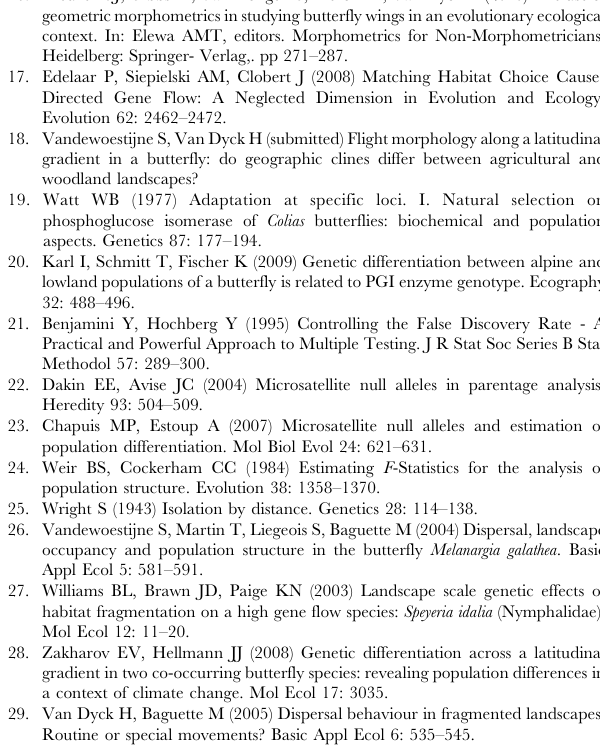
populations ( N ), dotted line: woodland populations ( D ). Significance levels are available in Table S4. Figure S2 Genetic and phenotypic differentiation. Fst and Pst values for agricultural-agricultural ( N ) and woodland-woodland ( D ) population pairs of size and dispersal relevant morphological variation (relative thorax, aspect ratio, wing loading and melanization). All values are with 95% confidence intervals. Figure S3 Spatial genetic autocorrelation correlogram of populations. Population pairs within A) agricultural and B) woodland landscapes. Dotted lines represent upper and lower 95% CI around the null hypothesis (no spatial structure). Filled dots represent significant r values (p , 0.05), empty dots non- significant values. Error bars indicate 95% CI of r estimated by bootstrapping (n =1000). the Biodiversity Research Centre of the